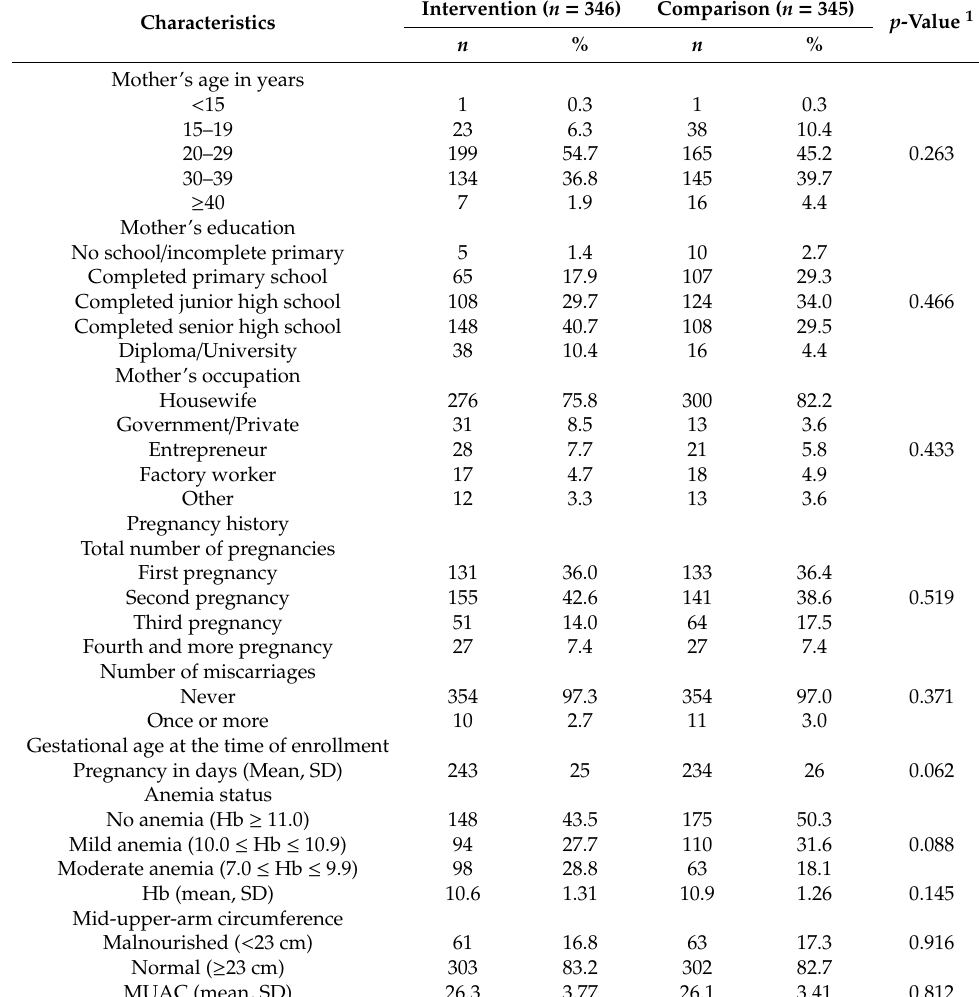
Table 3. Baseline characteristics of cohort mothers by treatment